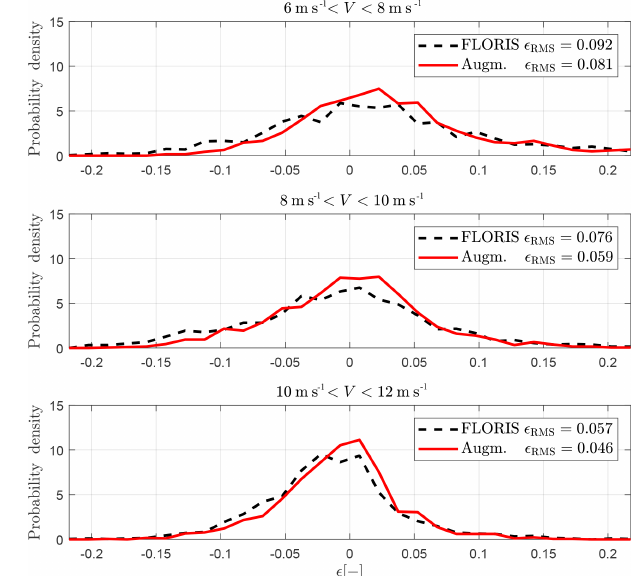
Figure 18. Error probability density functions for different wind speed